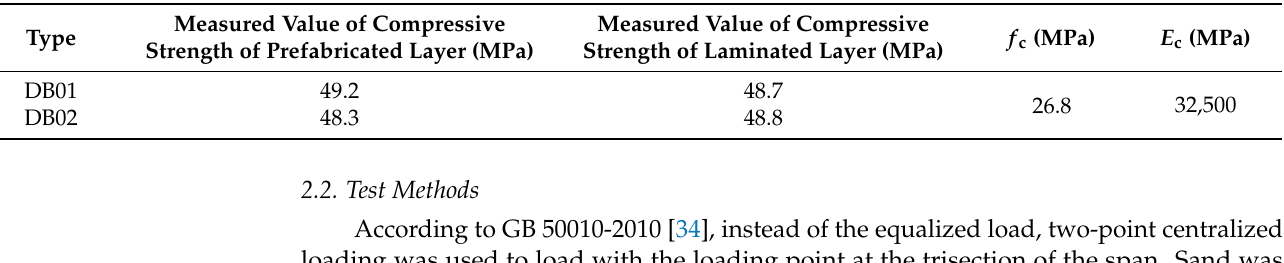
Figure 6. Loading device and failure mode under compression.